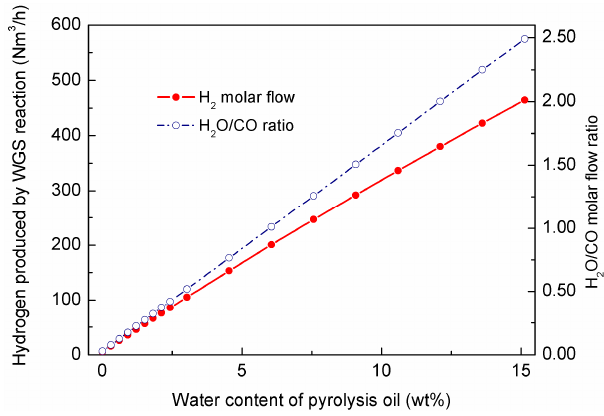
ff ects of water–gas-shift reaction on hydrogen Figure 12. Effects of water–gas-shift reaction on hydrogen production. Figure 12. E